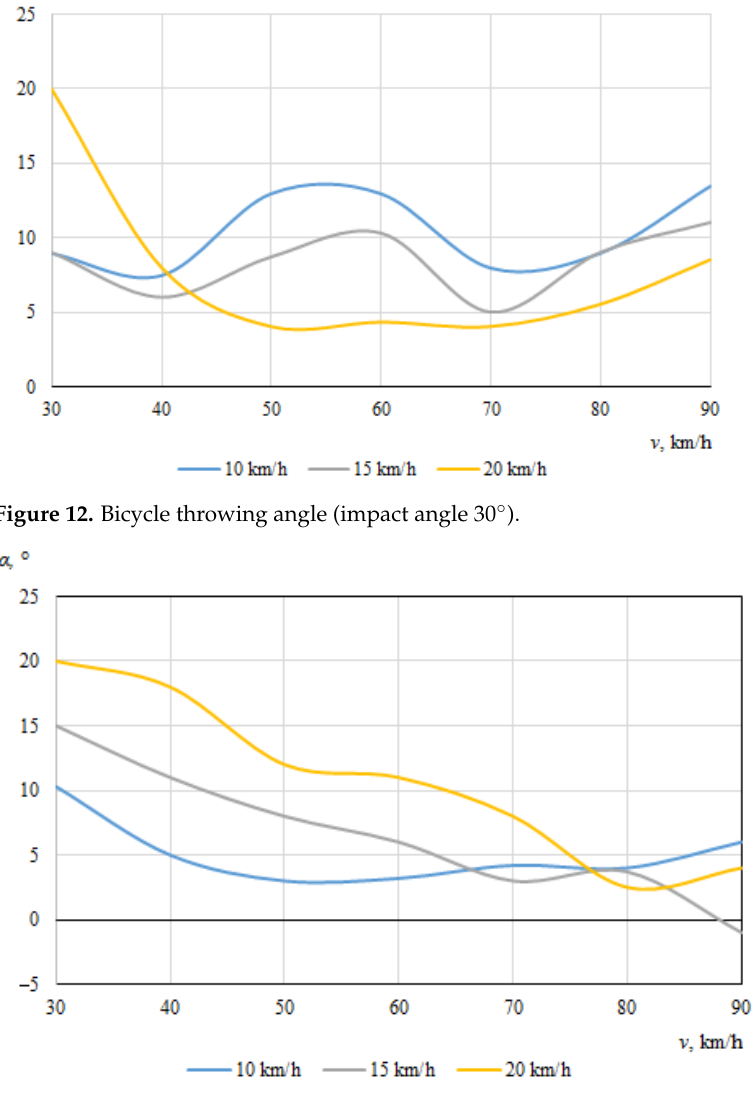
Figure 13. Cyclist throwing angle (impact angle 30°).